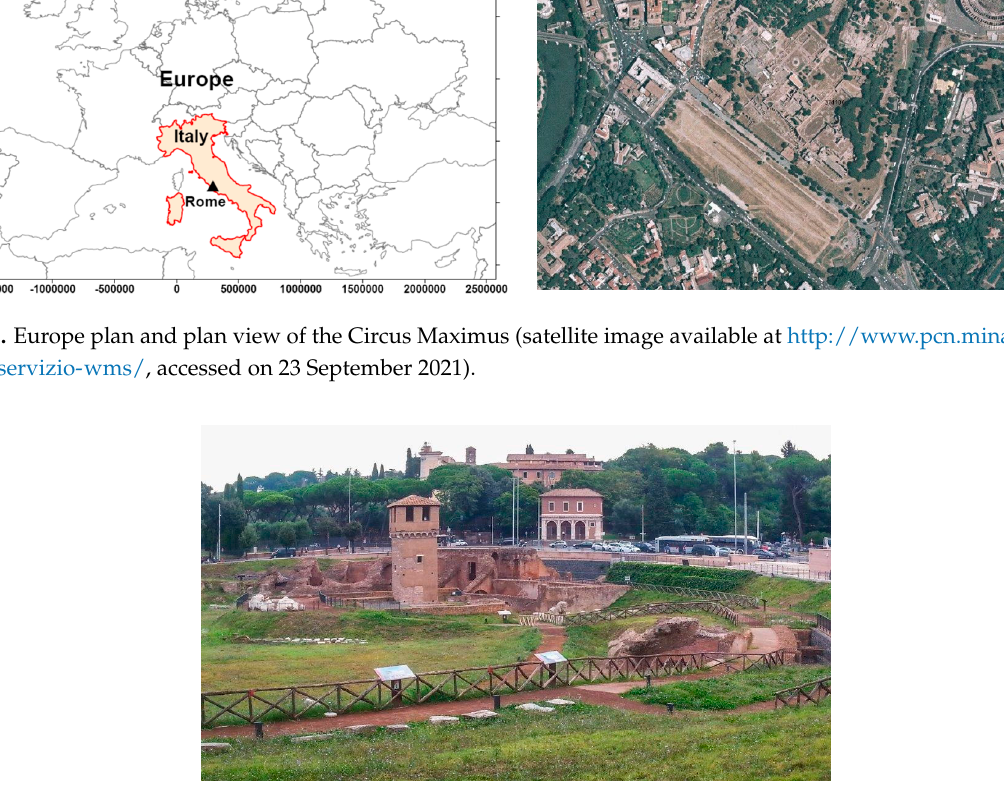
Figure 2. View of the south-east side with the ruins and the Torre della Moletta.